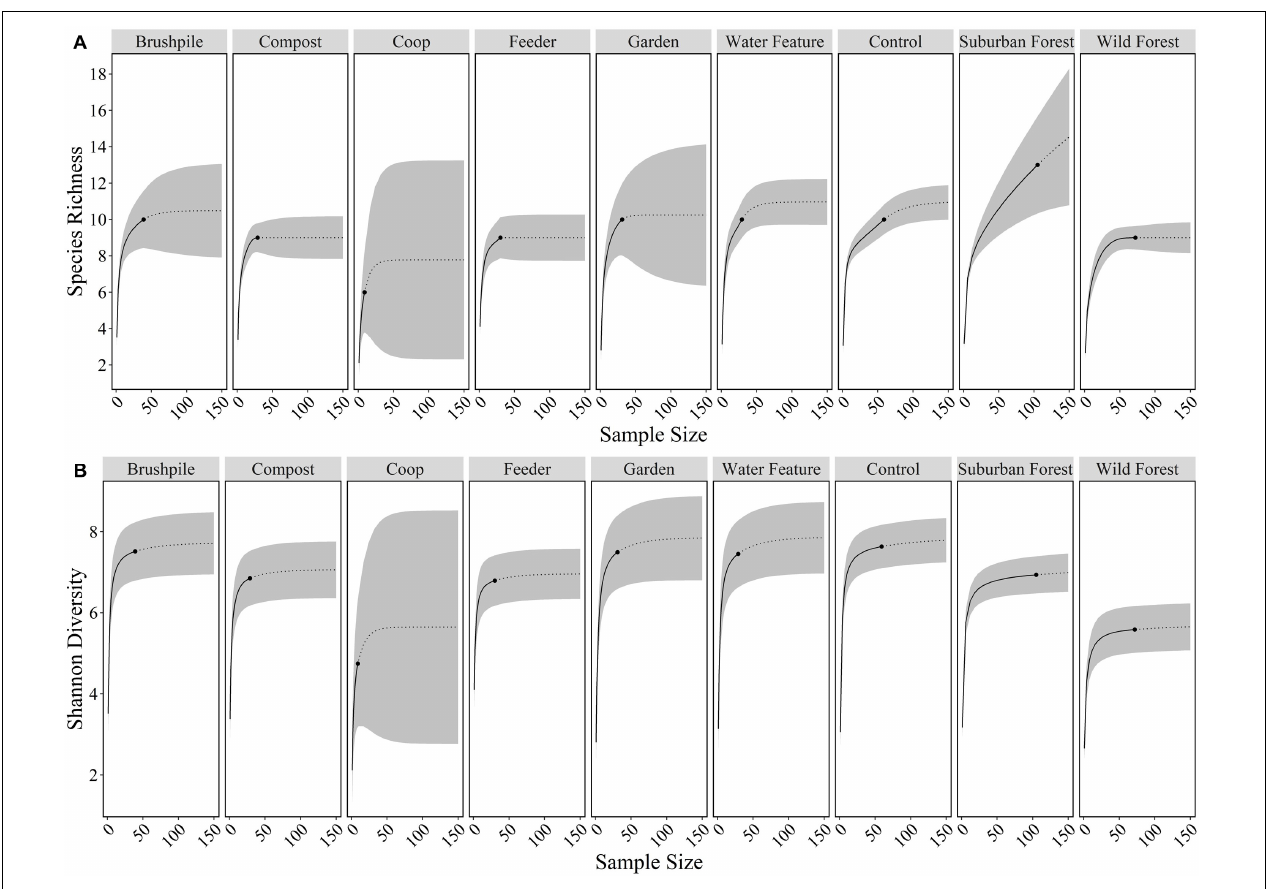
FIGURE 2 | Species richness (A) and Shannon diversity (B) of mammals at features in residential yards (brushpiles, compost piles, chicken coops, bird and mammal feeders, gardens, water features, control sites), suburban forests, and rural forests surrounding Raleigh, North Carolina from 2012 to 2016. Black dots are the observed species richness or diversity at a feature, solid lines are the interpolated values, dotted lines are the extrapolated values, and gray ribbons are the 95% confidence intervals across sample